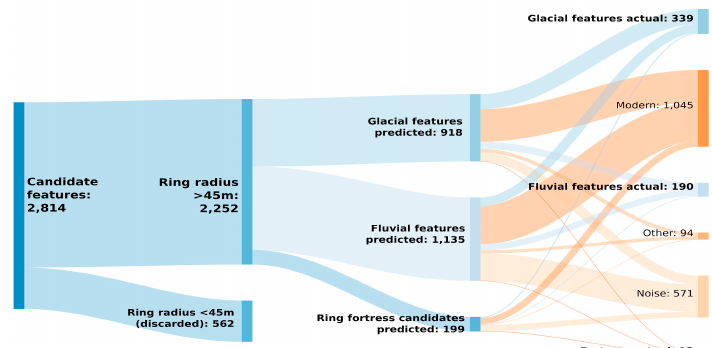
Figure 6. Sankey diagram showing the relationship between predicted and manual classifications. A high number of features are either modern or result from noise. Additionally, classes of features not included in the classification workflow were identified, including marine features related to relict beach ridges and other archaeological features not related to fortifications.